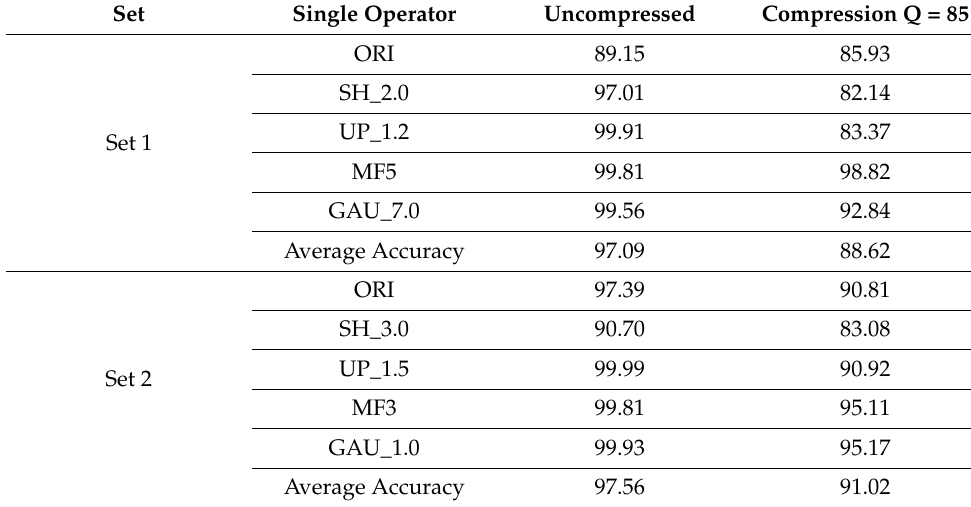
Table 3. Single operator